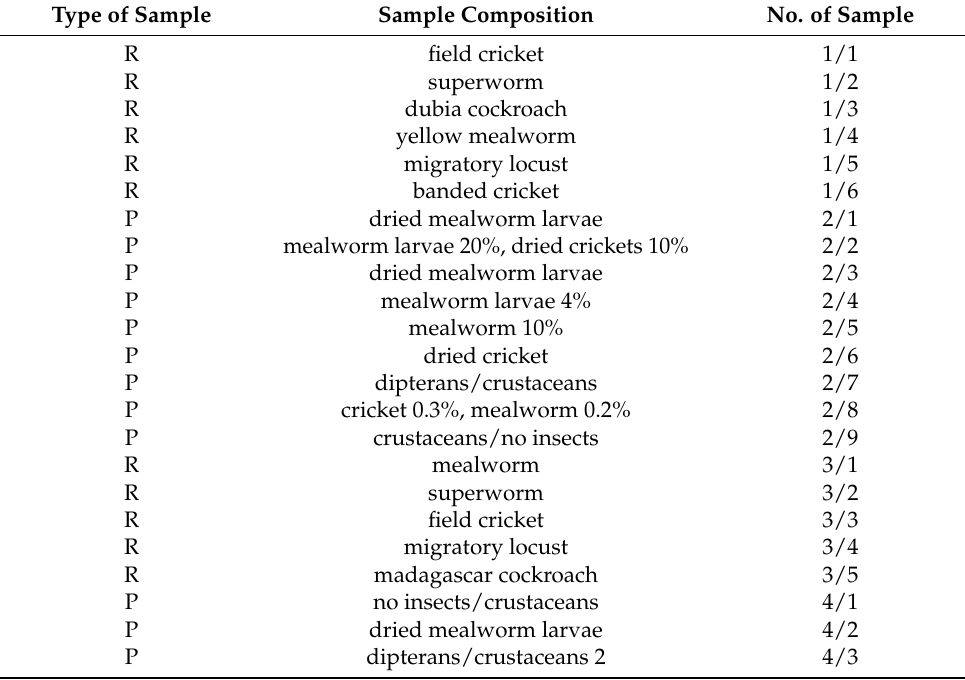
Table 1. Composition of test material, type of sample and code number used in the tests. Type of